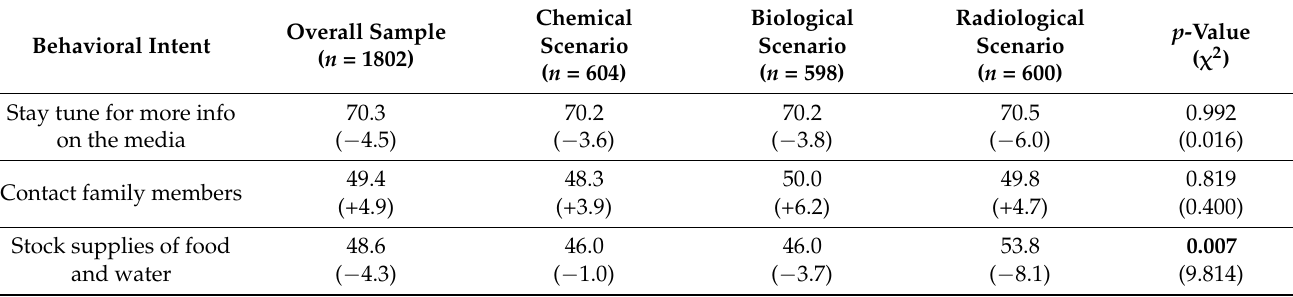
Table 5. Distribution of behavioral intents (% of top answers on Likert scale) in reaction to the non-conventional scenario presented and % of change (in brackets) if the scenario were to happen in the participant’s